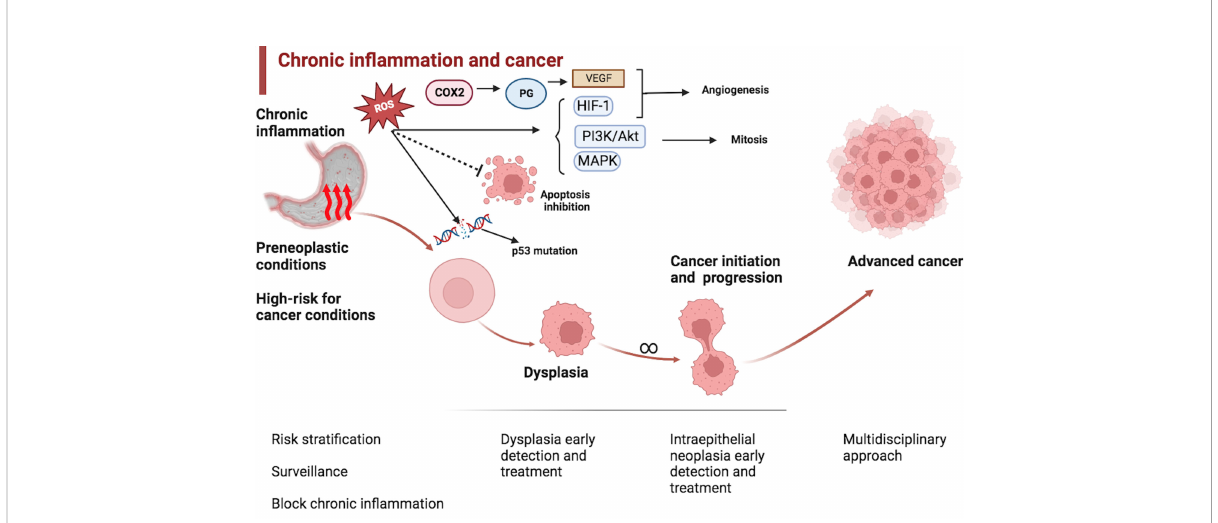
FIGURE 1 Chronic in fl ammation and esophagogastric cancer. Preneoplastic and high-risk cancer conditions are usually associated with the epithelium ’ s chronic in fl ammation. Chronic in fl ammation may promote oncogenesis through several pathways, including DNA damage, chromosomal instability, and mutations. Reactive oxygen species (ROS) inhibit apoptosis, and promote angiogenesis and proliferation. Clinicians should be ready to act at every stage of cancer initiation and progression, including blocking chronic in fl ammation, surveillance, risk strati fi cation, dysplasia and early cancer eradication, and advanced cancer management. COX2: Cyclooxygenase-2; PG: Prostaglandin; VEGF: Vascular endothelial growth factor; HIF-1: Hypoxia-inducible factor 1; PI3K/Akt: Phosphoinositide 3-kinases/Protein kinase B; MAPK: Mitogen-activated protein